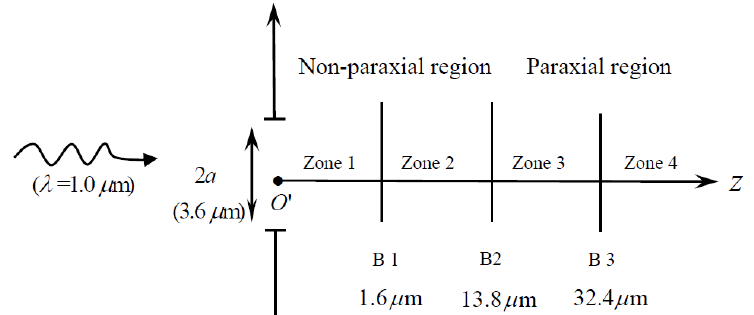
Figure 3. Schematic of the four zones behind the slit and the notations. The numbers indicated in the figure are explained below.